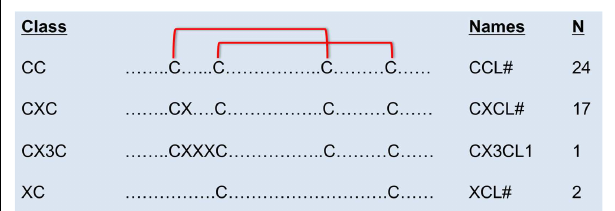
FIGURE 1 | Cysteine disulfide bonds in different classes of chemokines. In CC chemokines, the first two conserved cysteines are adjacent.The first and the third, and the second and the forth conserved cysteines form disulfide binds. In CXC chemokines, the first two conserved cysteines are separated by one amino acid. In the CX3C chemokine, three amino acids separate the first two conserved cysteines.There are only two conserved cysteines in the XC class of chemokines.The name and number of human members in each class of chemokines are on the right.